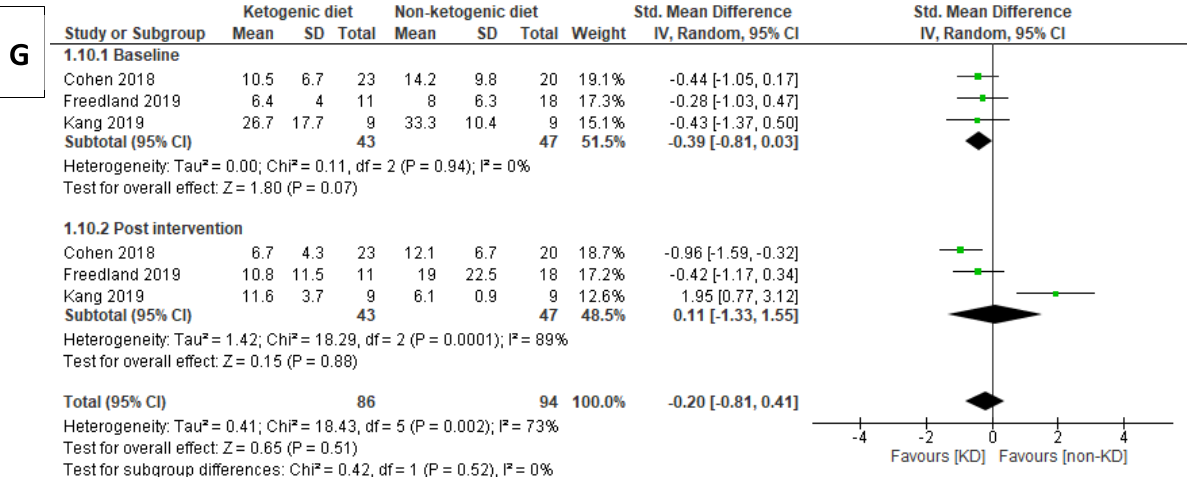
Figure 3. Forest plot for the subgroup effects of the baseline versus post ‐ intervention of ketogenic diet (KD) vs. non ‐ ketogenic diet on TC ( A ), HDL ‐ c ( B ), LDL ‐ c ( C ), TG ( D ), body weight ( E ), fasting blood glucose ( F ), and insulin ( G ).